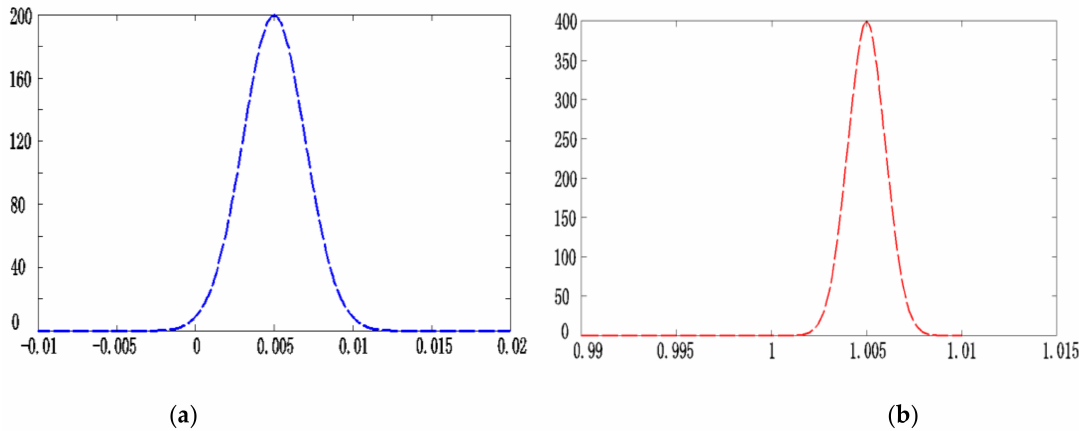
Figure 2. ( a ). Probability distribution of value a i ; ( b ). Probability distribution of value b i